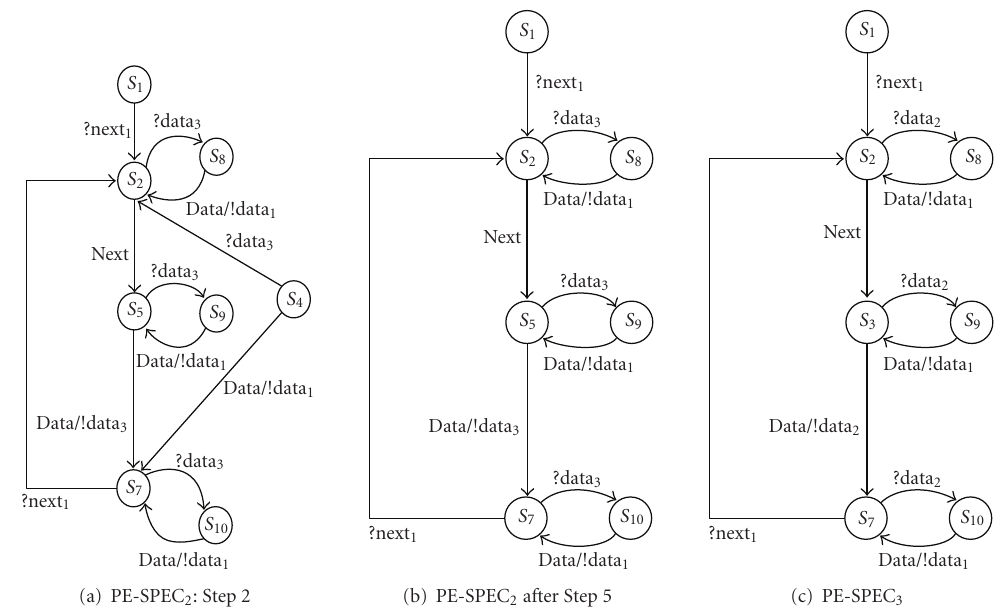
Figure 5: An application of the procedure given in Algorithm 4 for the PE-SPEC 2 and PE-SPEC 3 given in Figure